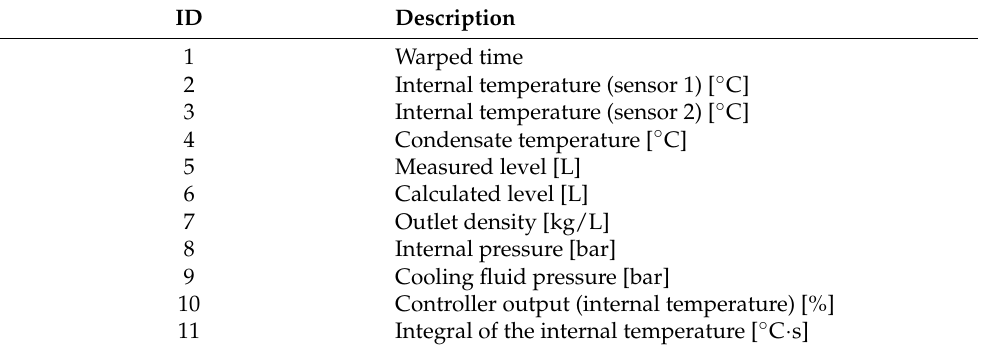
Table A3. List of the process variables analyzed for unit R202.